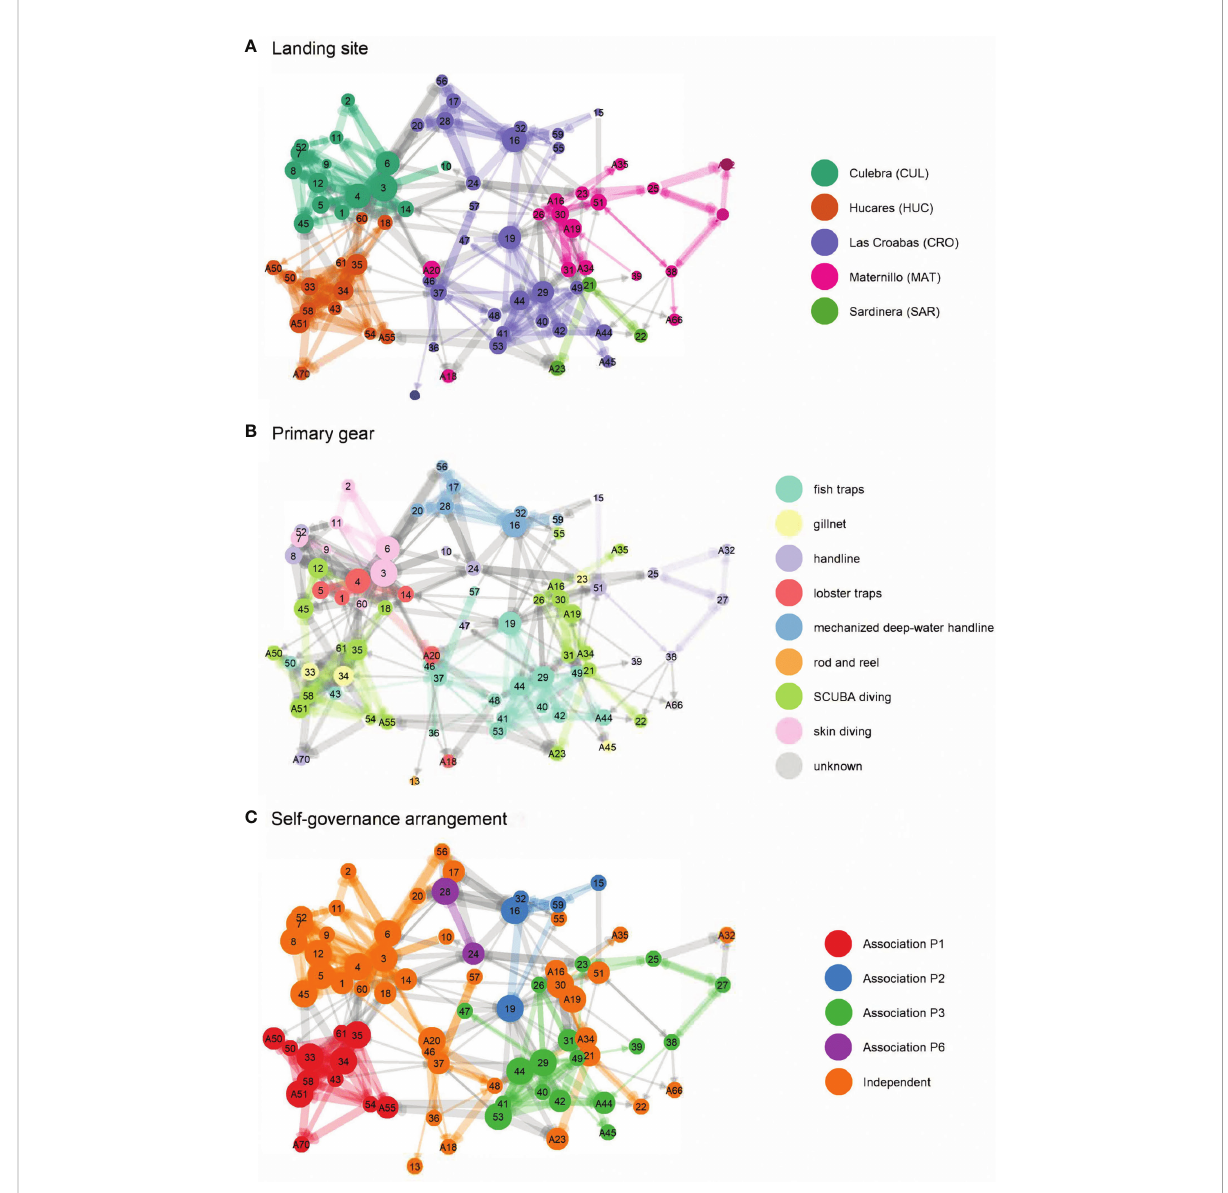
FIGURE 2 The information-sharing network among commercial fi shers of north-eastern Puerto Rico, highlighting key attributes used to compare (A) place- based communities as de fi ned by landing site, (B) knowledge-based as de fi ned by the common use of a primary gear type, and (C) organizational communities based on the same self-governance arrangement. Each circle (node) is a unique fi sher whose identity is anonymized. Each fi sher is represented by a number if they were surveyed (egos) or by a combination of a letter and number if not sampled (alter) but still inside the network boundaries. The layout uses a spring-embedder algorithm (Fruchterman & Reingold, 1991), which places high-degree centrality nodes in the center of the plot, so that fi shers that are more connected to each other, are closer together and less connected fi shers are farther apart. Node size displays degree centralities, a measure of the number of ties connecting an actor. The direction of communication is denoted by arrows. The width of ties represents the value placed by the fi sher on the information shared (Little, Moderate, or A lot). Ties are colored if they share node homophily to highlight possible cohesion